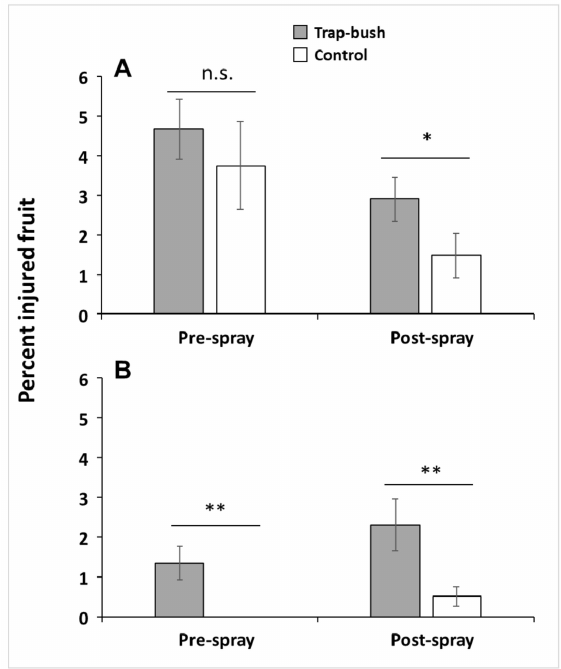
Figure2. Percent(mean ± SE)ofoviposition-scarredfruitby Conotrachelusnenuphar adultsinodor-baited trap bushes and unbaited bushes in trap-bush and control plots, respectively, in 2013 ( A ) and 2014 ( B ). Fruit injury was assessed before and after a post-bloom insecticide application. Asterisks indicate significant di ff erences according to Welch’s two-sample t -test (* = 0.01 < p ≤ 0.05; ** = p ≤ 0.01); n.s. = not significant ( p >